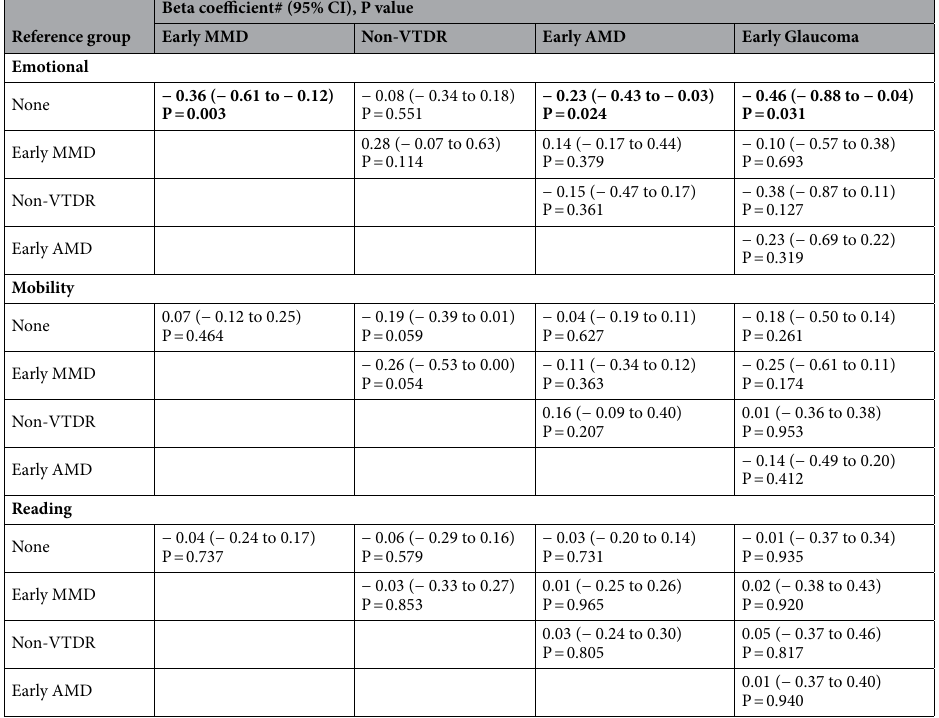
Table 3. Multivariable-adjusted pairwise comparisons of each IVI domain between early stage eye diseases. Adjusted for age, gender, race, education, income, housing, BMI, smoking, alcohol, any systemic disease & PVI better eye. Systemic diseases include diabetes mellitus, arterial hypertension, hyperlipidaemia, CVD & CKD. Significant values are in [bold]. BMI body mass index, CVD cardiovascular disease, CKD chronic kidney disease, PVI presenting visual impairment, VTDR vision threatening diabetic retinopathy, AMD age related macular degeneration, MMD myopic macular